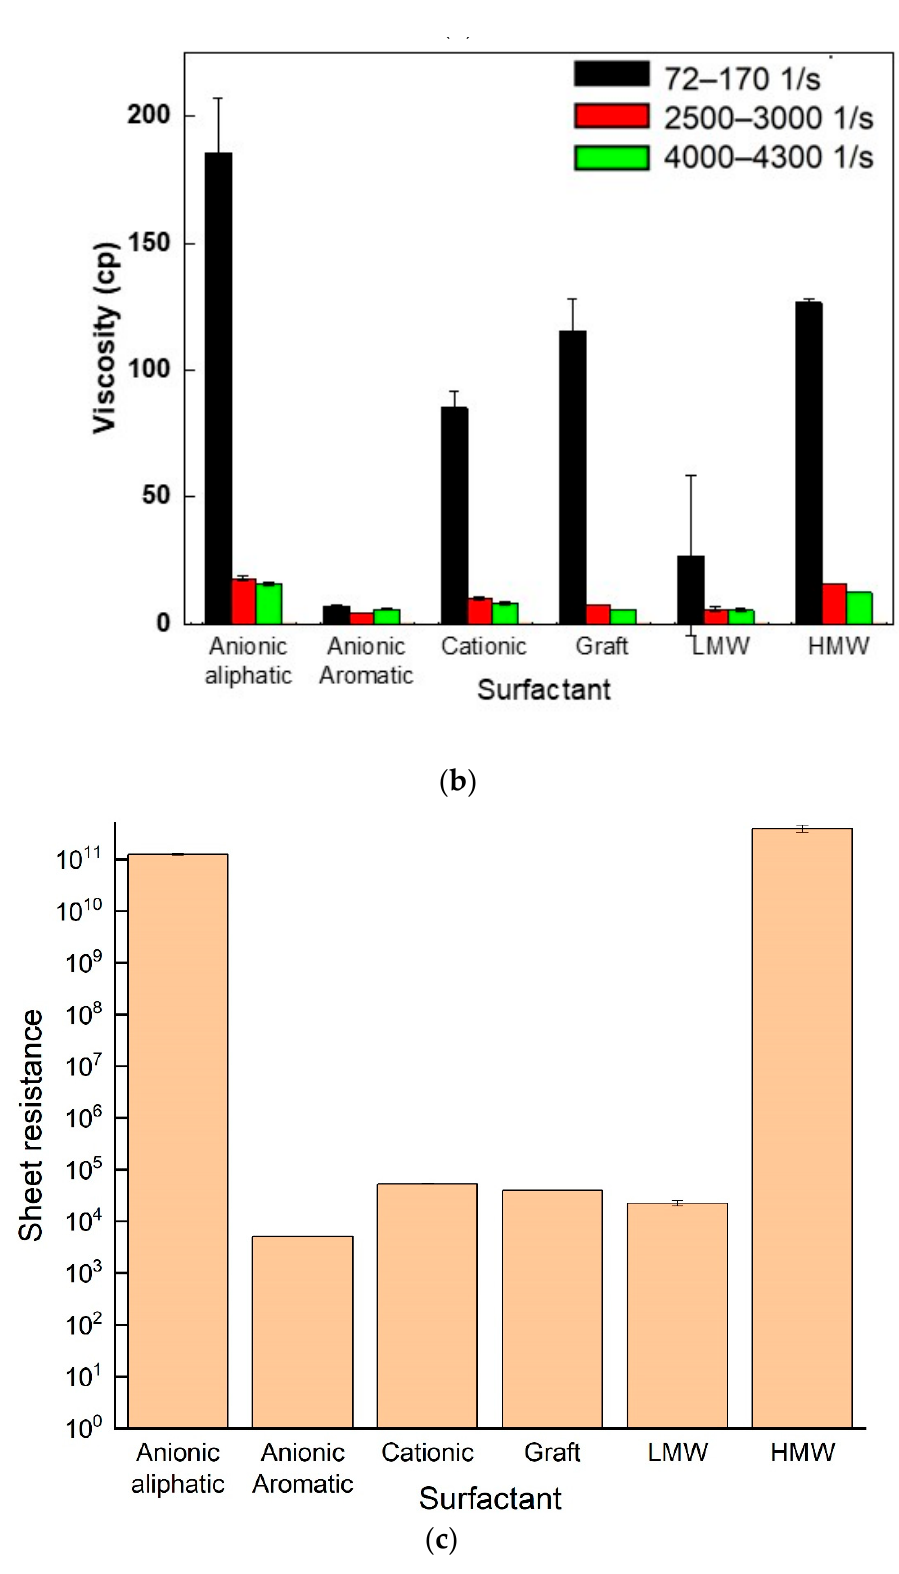
Figure 7. Absorbance intensity ( a ), viscosity in various shear rates ( b ), and sheet resistance ( c ) values of SWCNT suspensions dispersed in various surfactants. Table 3. LVR values and crossover point (Pa) for SWCNT suspensions dispersed in various surfac- tants.